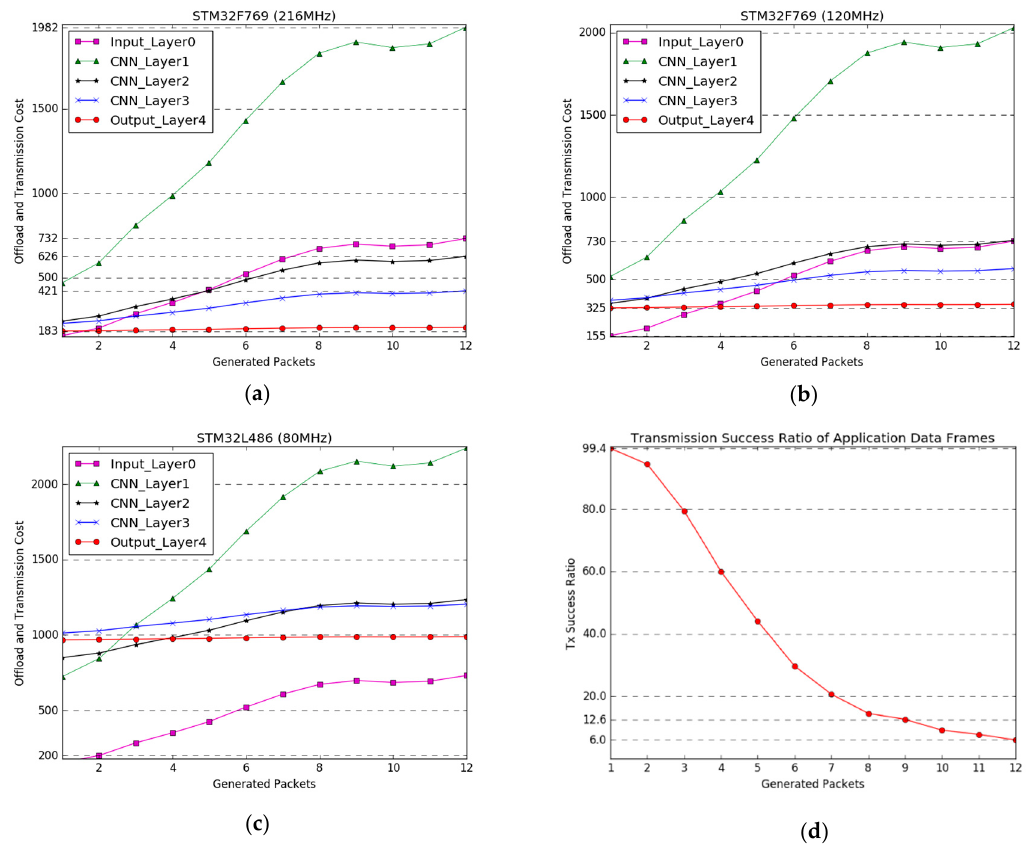
Figure 6. Experimental results for our proposed offload and transmission strategy based on the measured network performance metrics and deep learning structure in Figure 4 and its parameters in Table 2. ( a – c ) present the offload and transmission cost considering computation performance (operation clock speed), the number of packets generated in the corresponding layers, and media channel status. The horizontal axes of graphs ( a – c ) indicate packets-per-second generated by neighboring nodes at each send interval, representing the channel congestion level. ( d ) shows the transmission success ratio according to the number of fragmented packets generated in the application layer.